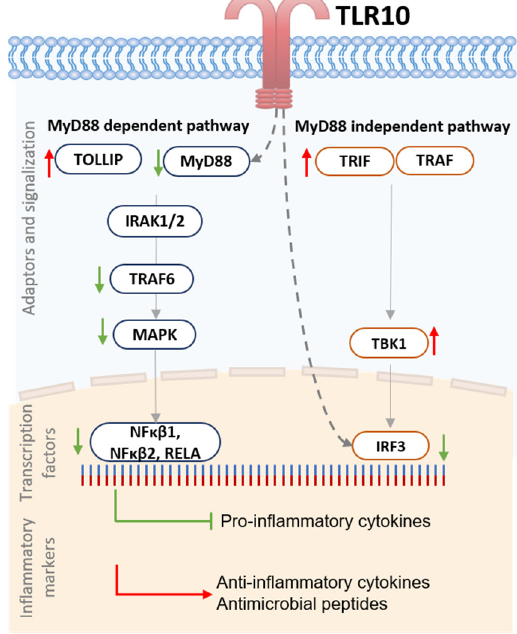
Figure 5. Schematic representation of proposed regulation of TLR10. Scheme of differentially expressed adaptors, transcription factors, and inflammatory markers involved in MyD88-dependent and -independent pathway in challenged A549-TLR10 OE. In MyD88-dependent pathway, TLR10 possibly acts through binding to MyD88. However, it seems assembly is unable to form active signalosome, resulting in downregulation of downstream genes. In MyD88-independent pathway, it is believed that TLR10 does not bind adaptor proteins such as TRIF or TRAM, yet expression of transcription factor IRF-3 was downregulated. Possible mechanisms are scavenging dsRNA away from TLR3 and suppressing activation of IRF-pathway, or that an unknown mechanism affects signal transmission from TBK1 to IRF3. Green arrow, downregulation; Red arrow, upregulation; Grey dashed arrow; possible effect of TLR10. Abbreviations: Interleukin-1 receptor-associated kinase 1,2 (IRAK1/2), Interferon regulatory factor 3 (IRF3), Mitogen-activated protein kinase (MAPK), Myeloid differentiation primary response 88 (MyD88), Nuclear factor NF-kappa- β p105 subunit (NF κβ 1), Nuclear factor NF-kappa- β p100 subunit (NF κβ 2), Nuclear factor NF-kappa- β p65 subunit (RELA), TANK-binding kinase 1 (TBK1), TIR-domain-containing adapter-inducing interferon- β (TRIF), TIR domain-containing adapter molecule 2 (TRAM), TNF receptor-associated factor 6 (TRAF6), Toll interacting protein (TOLLIP).